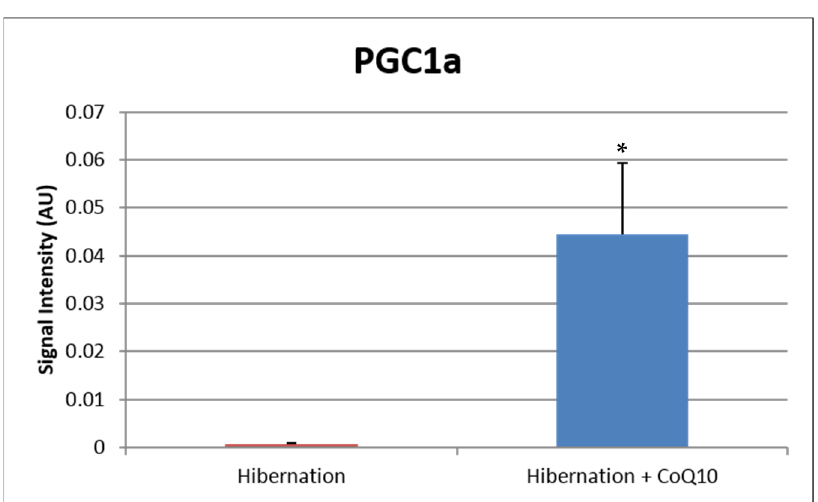
Figure 4. In a pre-clinical swine study of chronic myocardial ischemia, administration of CoQ 10 (400 mg/day) in the chow for 4 weeks increased the expression of activated PGC1-alpha, the master switch for mitochondrial biogenesis, leading to enhanced expression of mitochondrial antioxidant proteins in the chronically ischemic territory. The data support the concept that CoQ 10 is protective by transcriptionally regulating antioxidant proteins in heart tissue. * p < 0.05. Table 1. Mitochondrial anti-oxidant proteins. Antioxidant Protein Accession # p Value